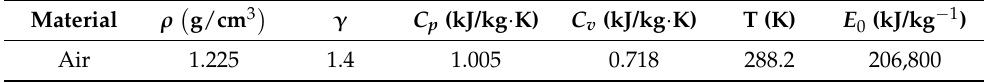
Table 5. Material parameter of